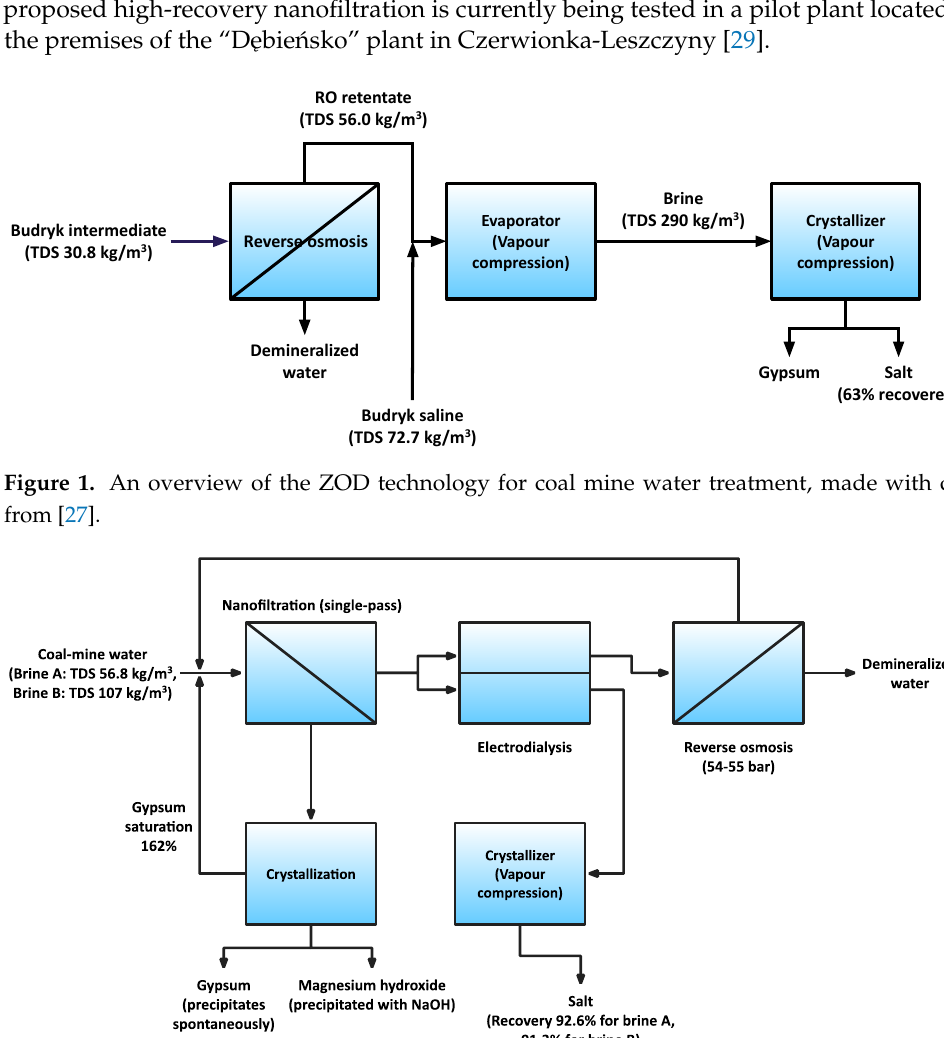
Figure 1. An overview of the ZOD technology for coal mine water treatment, made with data from [27].